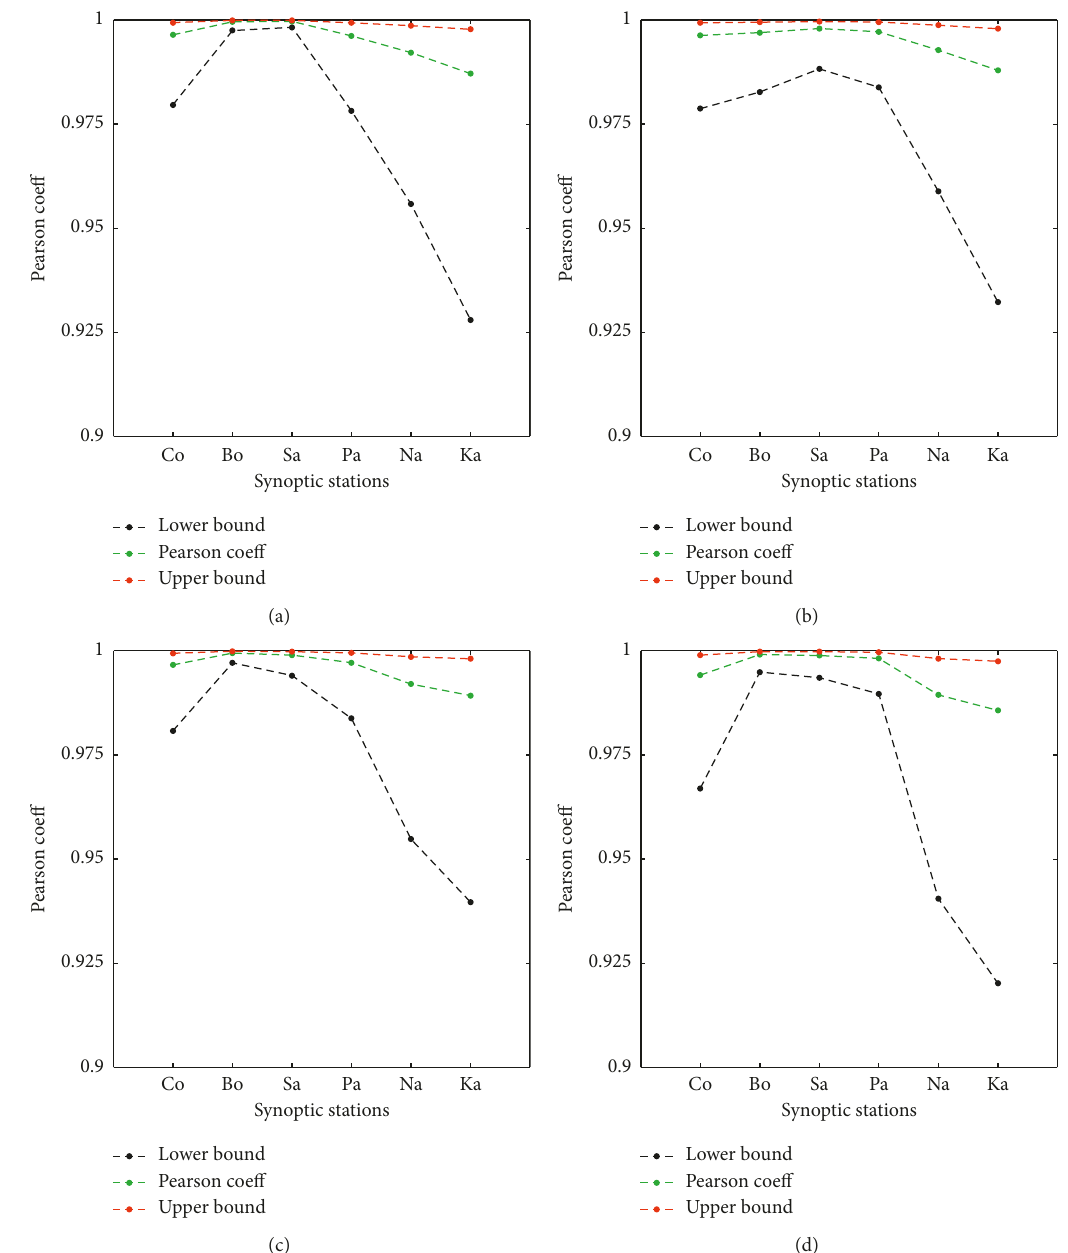
Figure 7: Spatiotemporal variation of Pearson coefficient for DFA exponent: (a) from 1951–2010, (b) from 1951–1970, (c) from 1971–1990, and (d) from 1991–2010. Red and black represent the upper bound and the lower bound of the 95% confidence interval. Green represents the Pearson